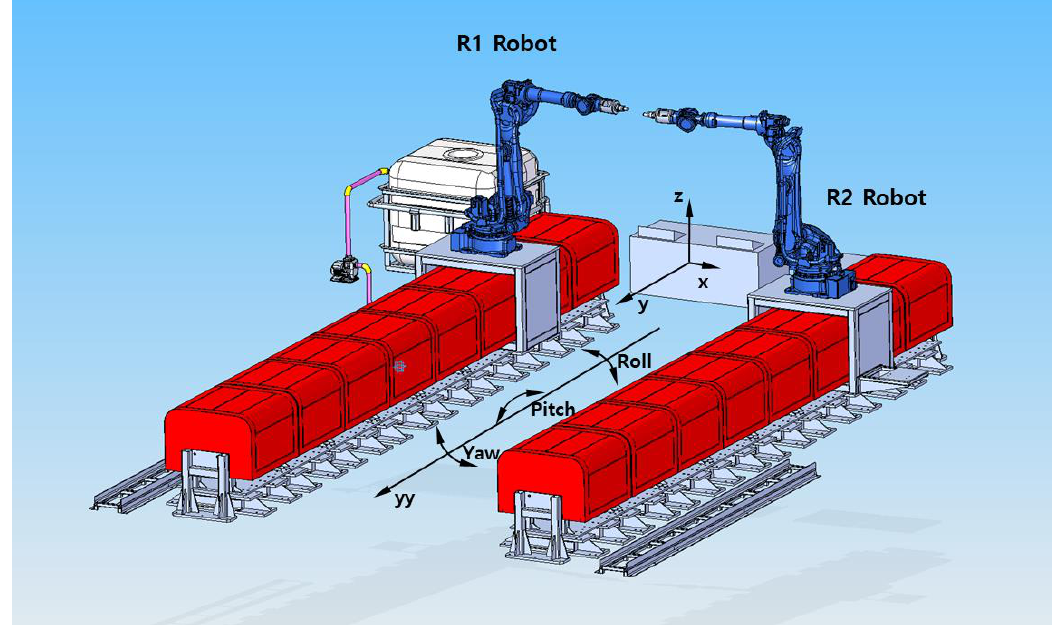
Figure 5. Robot coordinate setting for collecting coordinate values.